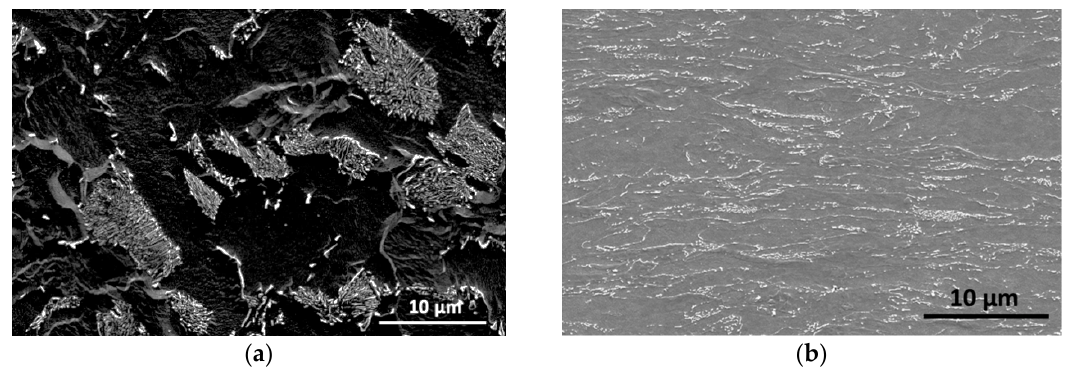
Figure 1. SEM observations of the etched microstructures of studied steel after ( a ) hot-rolling and coiling operations and ( b ) after further cold-rolling operation. Cementite in lamellar pearlite and isolated carbides appear in clear contrast whereas the ferrite matrix appears in dark contrast. After cold-rolling, ferrite grains and pearlite islands are elongated in the rolling direction.